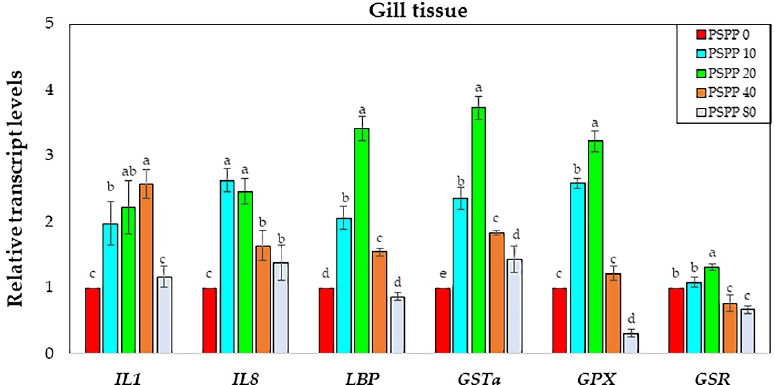
Figure 3. Expression transcript levels of interleukin ‐ 1 ( il ‐ 1 ), interleukin ‐ 8 ( il ‐ 8 ), lipopolysaccharide ‐ binding protein ( lbp ), glutathione S ‐ transferase ‐α ( GST ‐α ), glutathione peroxidase ( gpx ), and glutathione reductase ( gsr ) in gill tissues of Nile tilapia ( n = 5) fed diets supplemented 0 g kg − 1 PSPP, 10 g kg − 1 PSPP, 20 g kg − 1 PSPP, 40 g kg − 1 PSPP, and 80 g kg − 1 PSPP after eight weeks of feeding. The mRNA transcript levels of immune and antioxidant genes were normalized by 18S rRNA . The mRNA transcript level of the 0 g kg − 1 PSPP control group was set at 1. Data are presented as mean ± SE. Significantly different levels are denoted by superscript letters ( p < 0.05).